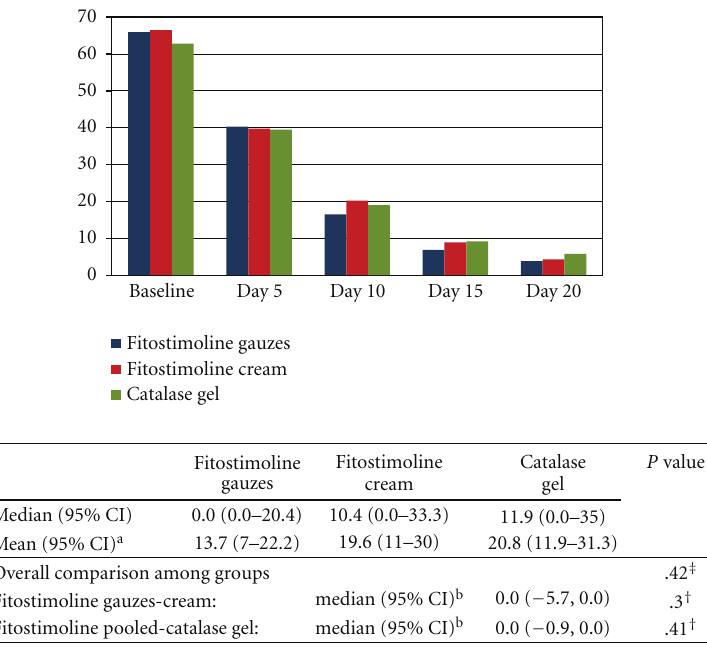
Figure 1: Mean values of largest burn diameter (mm) during the study and results of comparisons between groups at Day 10 (e ffi cacy